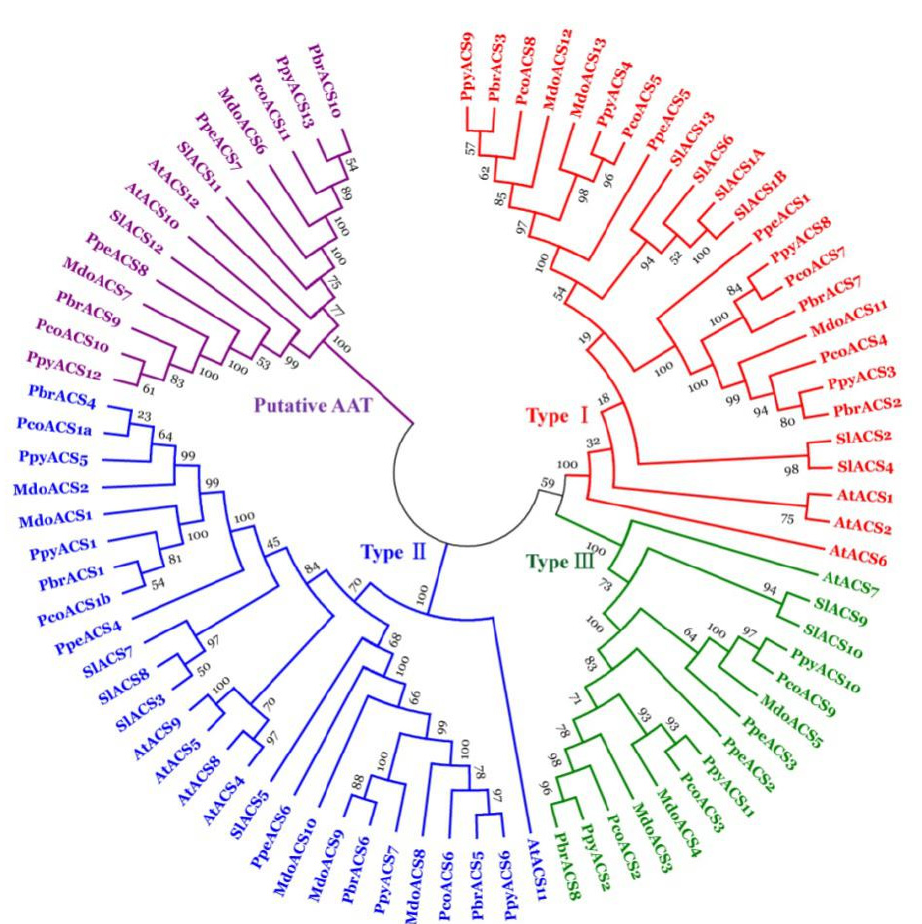
Figure 4. Phylogenetic analysis of ACS proteins from five Rosaceae species ( Pyrus pyrifolia , Pyrus bretschneideri , Pyrus communis , Malus domestica and Prunus persica ), and two non-Rosaceae species ( Arabidopsis thaliana and Solanum lycopersicum ). The phylogenetic tree was constructed using MEGA7.0 software by the neighbor-joining method. Different colors indicate different subfamilies of ACS.